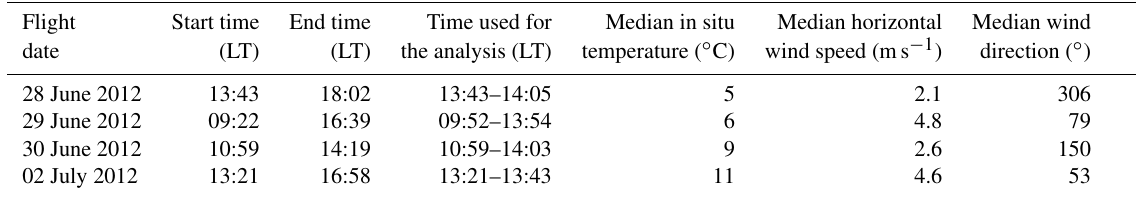
Figure 1. Flight lines from the 2012 airborne survey over the North Slope of Alaska that were used in the analysis. The dark blue flight lines were more frequently surveyed than the light blue lines. The insert shows the location of the EC tower in Atqasuk that was used for the comparison in Sect. 3.4. Map data: Google, DigitalGlobe. Table 1. Details of the Polar 5 survey flights carried out in 2012 over the North Slope of Alaska, the time intervals used in the analysis, and median values for meteorological parameters averaged over these time